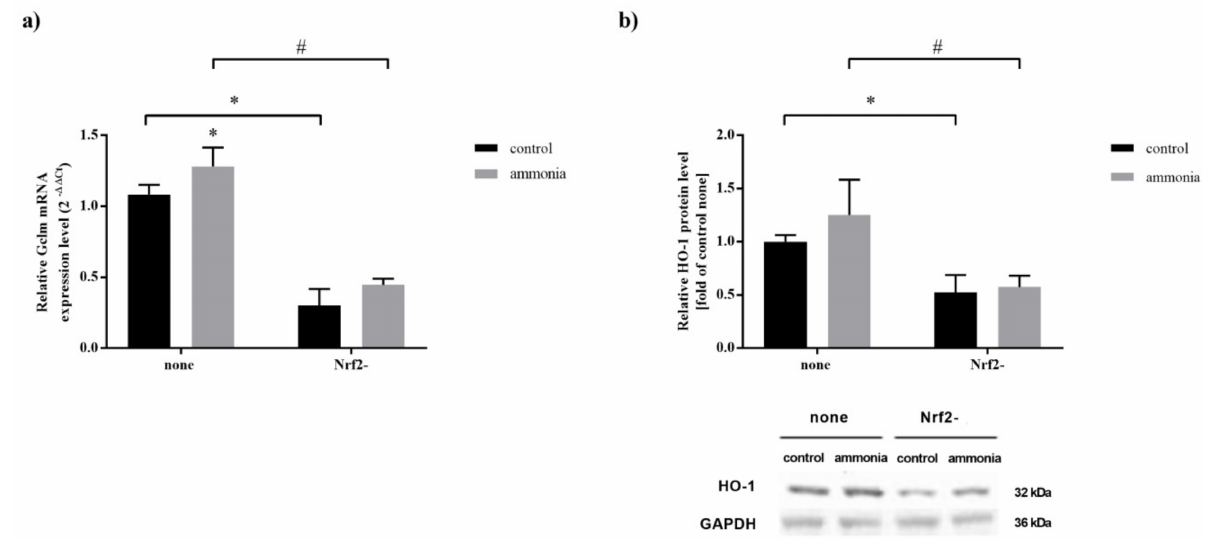
Figure 4. The effect of Nrf2 silencing (Nrf2-) on the Gclm mRNA level and HO-1 protein level in mouse astrocytes in the absence or presence of 5 mM ammonia for 24 h. ( a ) Gclm mRNA level. ( b ) HO-1 protein level. Results are the mean ± SD